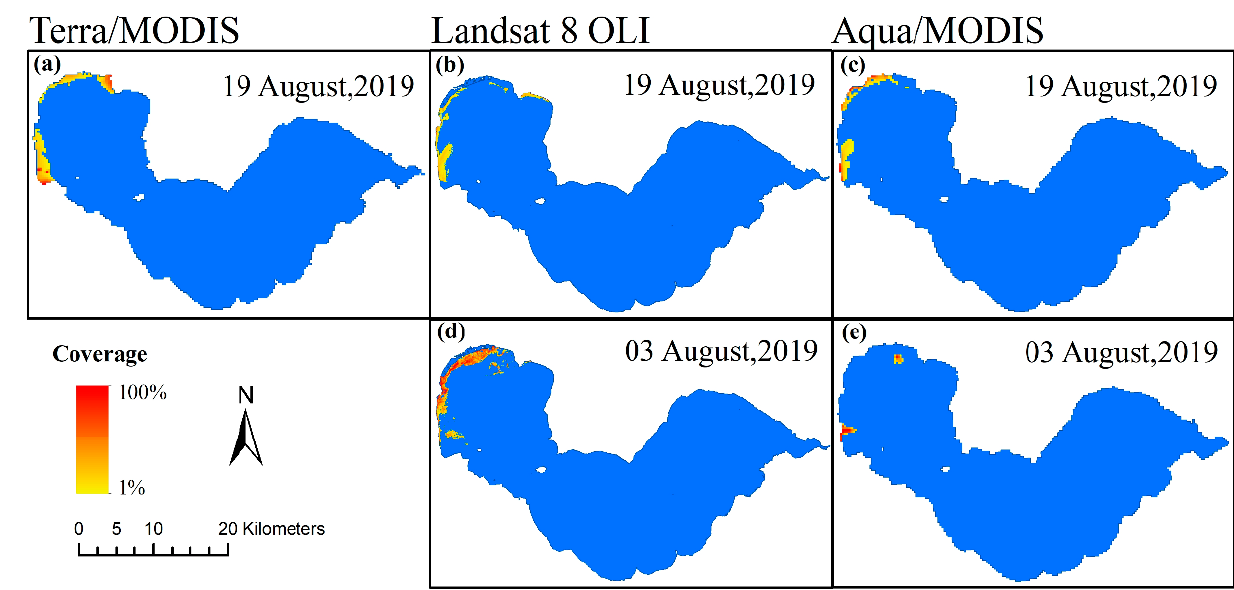
Figure 12. Harmful algal blooms from Terra/MODIS ( a ), Landsat 8 OLI ( b , d ), and Aqua/MODIS ( c , e ).